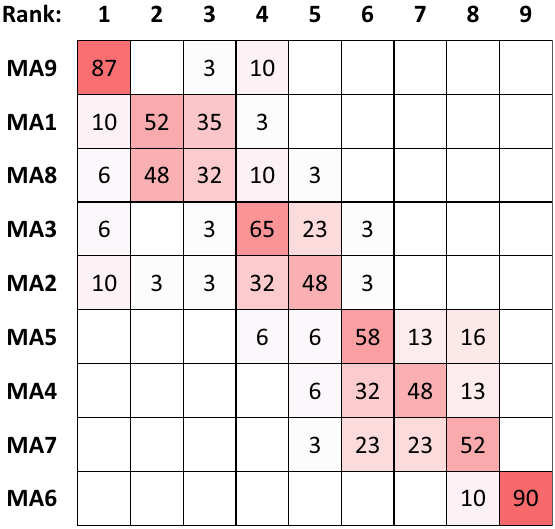
Figure 1. Ranking Strength over all normalization/aggregation combinations.